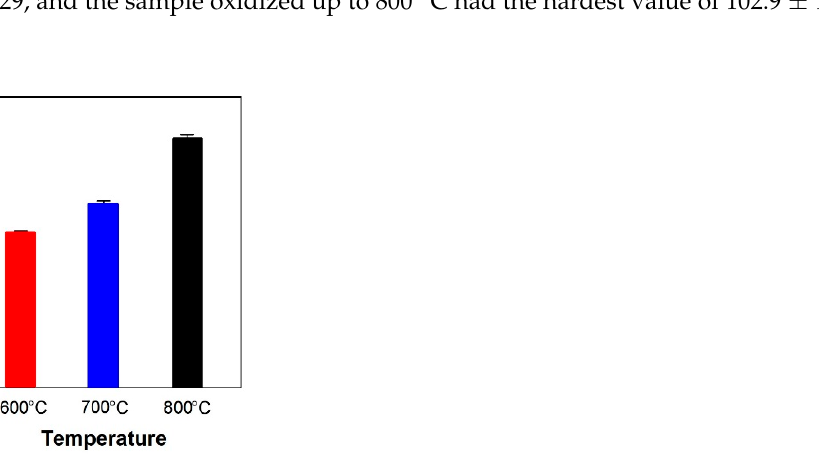
Figure 17. Comparison of the hardness for samples after oxidation up to 600 °C, 700 °C and 800 °C.